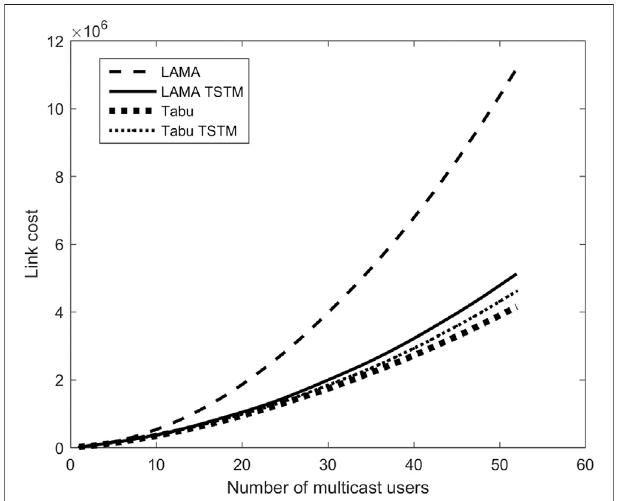
FIGURE 5 | The link cost of multicast trees on different algorithms.